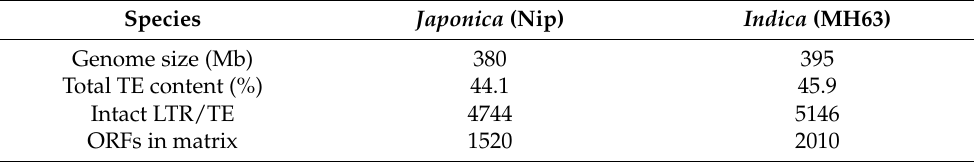
Table 1. Genome size, TE content, and intact TE ORF statistics of two rice